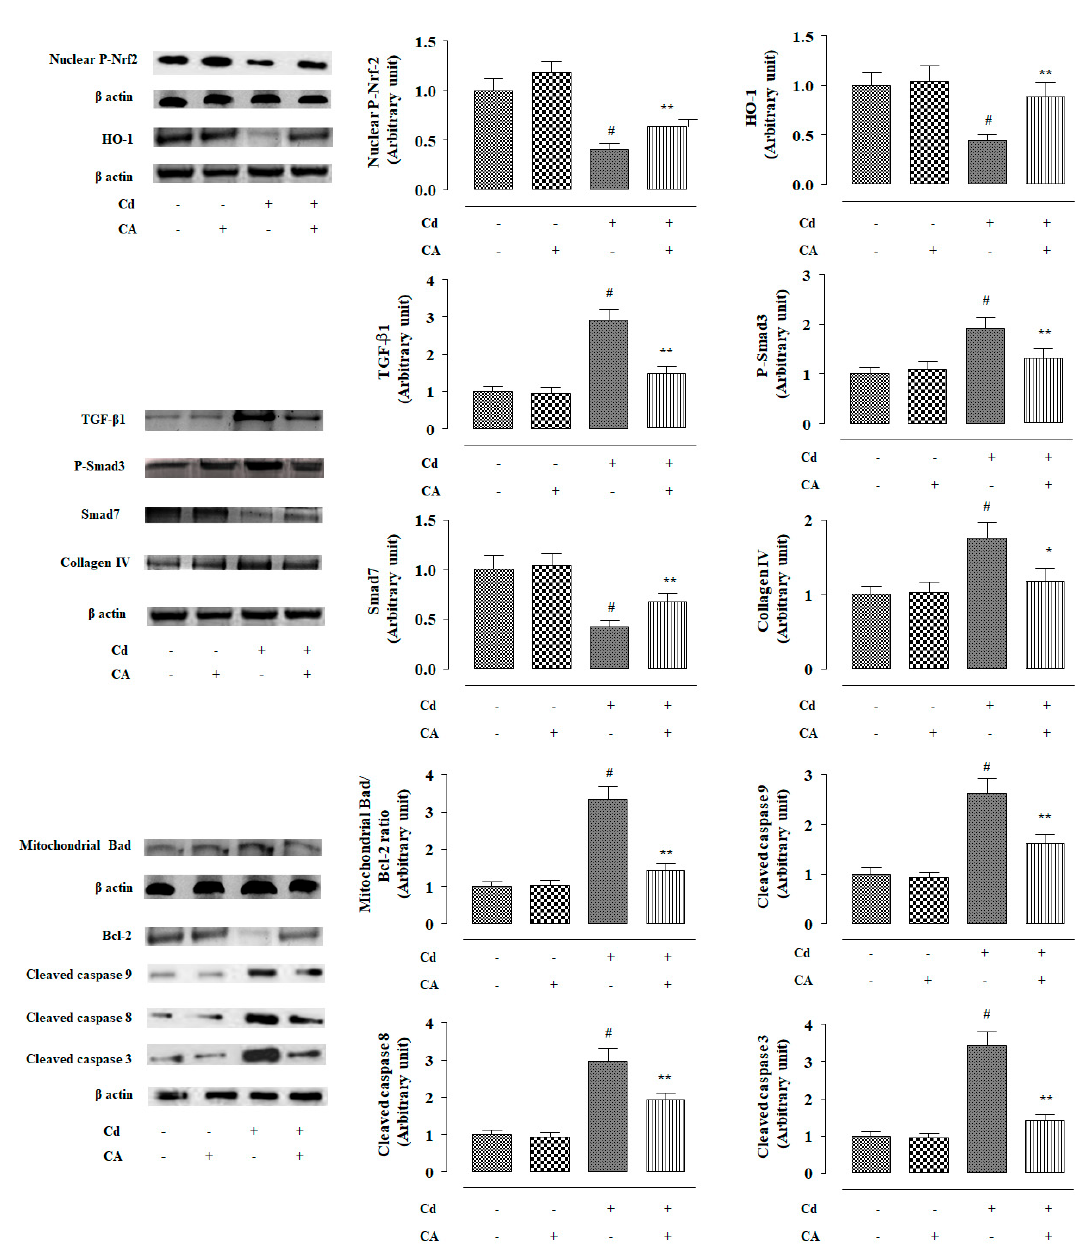
Figure 3. The effects of CdCl 2 and/or CA on signal transduction in vitro on NKE cells. The relative band intensities were measured and the intensity of the normal control band was chosen as 1. β -actin served as loading control. Data are represented as the mean ± SD, n (number of plates) = 3. # Values significantly ( p < 0.01) differed from the vehicle-treated group. * Values significantly ( p < 0.05) differed from only the CdCl 2 -treated group. ** Values significantly ( p < 0.01) differed from only the CdCl 2 - treated group.